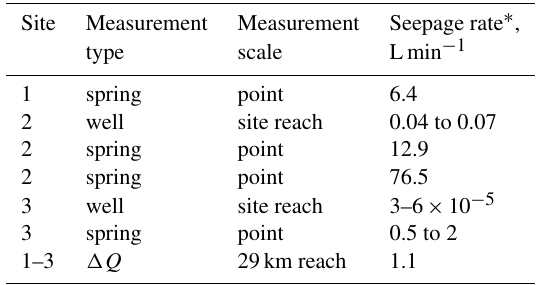
Table 3. Rates of measured or calculated groundwater discharge. (cid:49)Q is the difference in river flow between two USGS gaging sta-